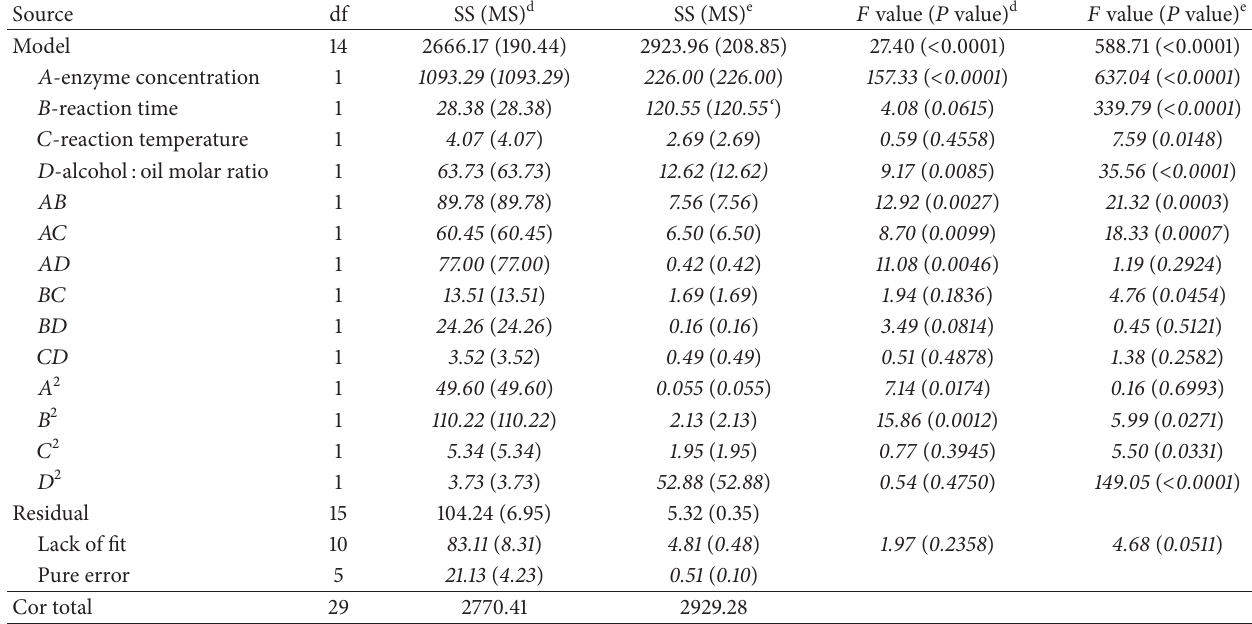
Table 4: Response surface quadratic model analysis of variance (ANOVA) for enzymatic transesterification of palm oil.